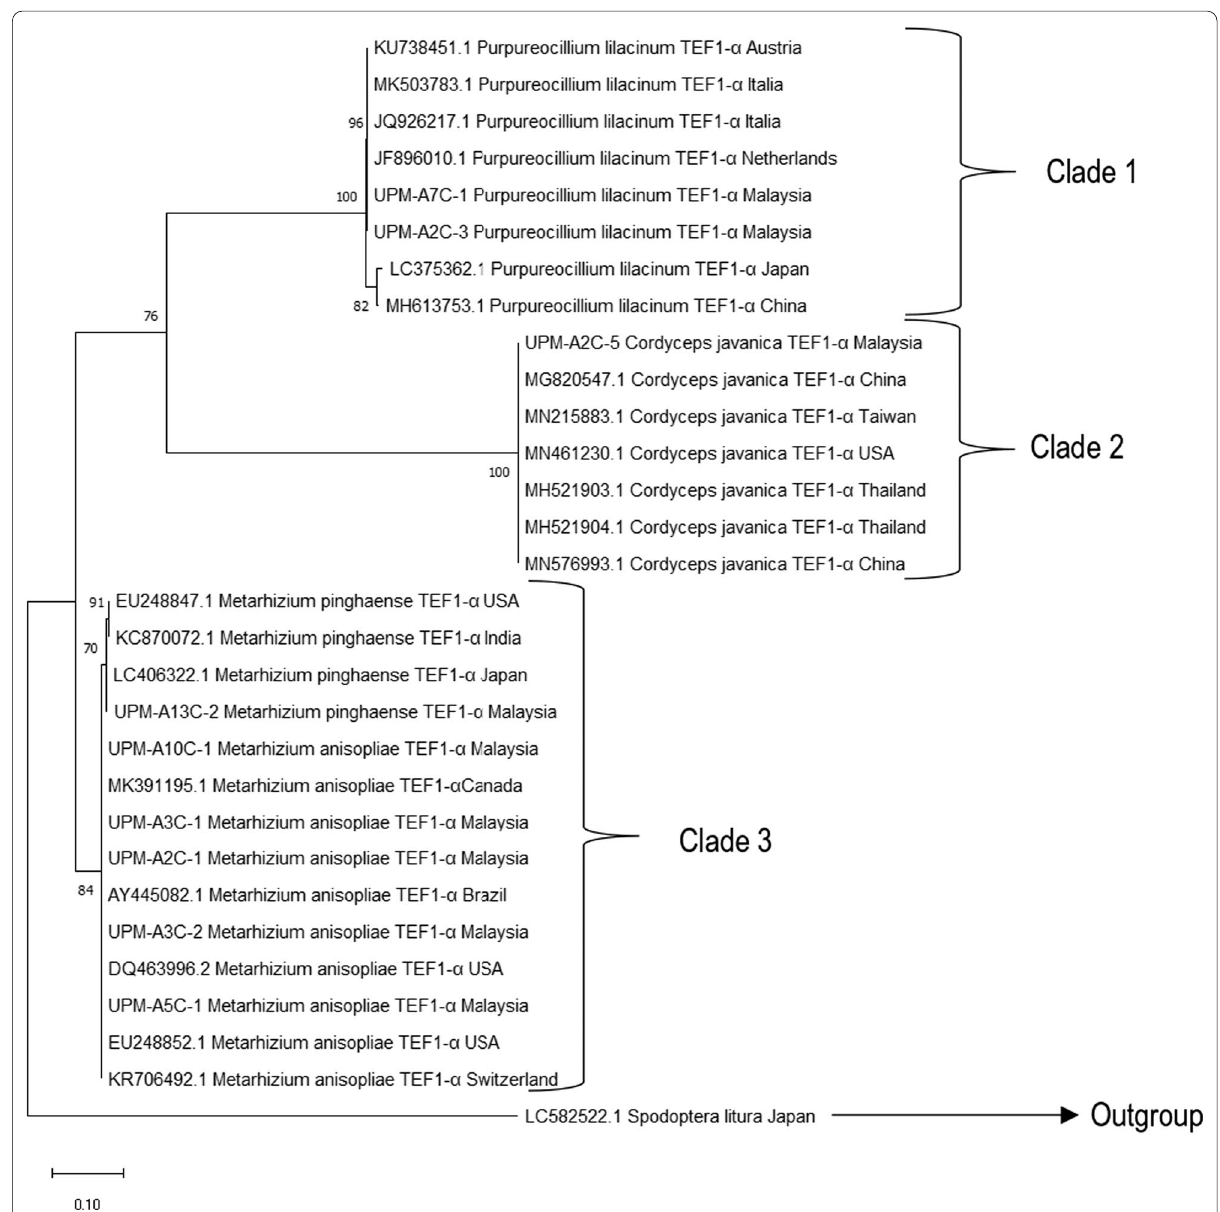
Fig. 3 Phylogenetic tree of TEF1-α gene of EPF. Maximum Likelihood Tree generated based on the combined dataset of TEF1-α nucleotide sequence of UPM EPF isolates developed using MEGA X. Only data with bootstrap value > 30% are shown. Models with the lowest BIC scores (Bayesian Information Criterion) are considered to describe the substitution pattern the best, Tamura 2-parameter